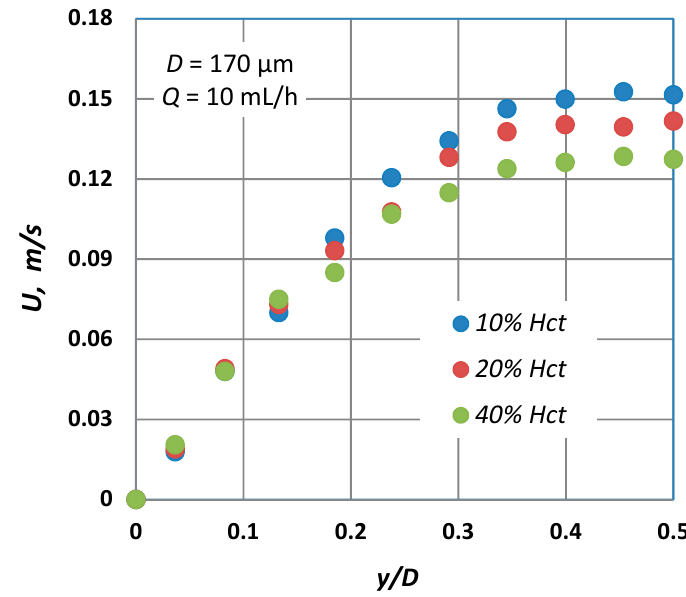
Figure 7. Typical velocity profiles at D = 170 µ m for three di ff erent H ct values ( Q = 10 mL / h) using the micro particle method.